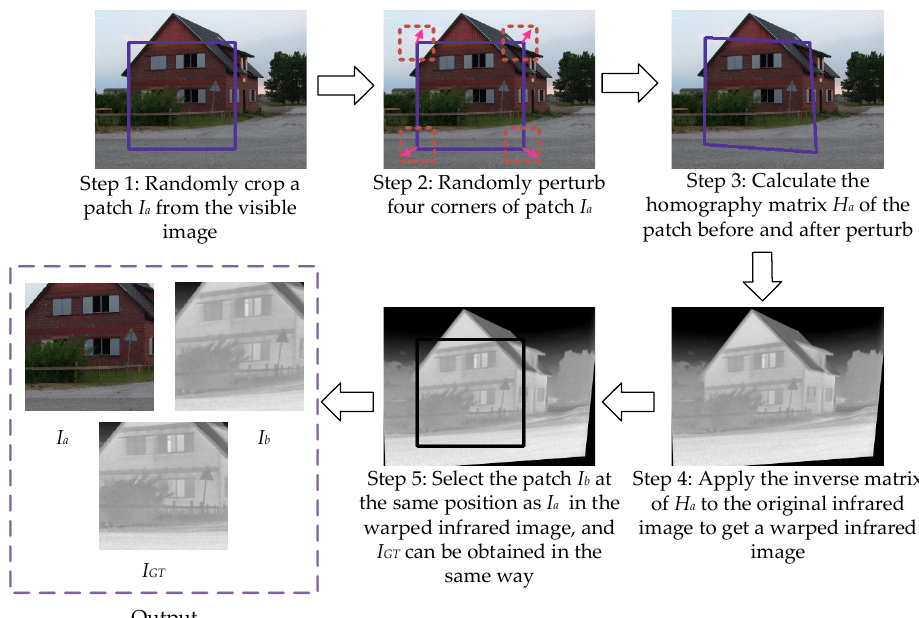
Figure 5. Production process of synthetic benchmark dataset.